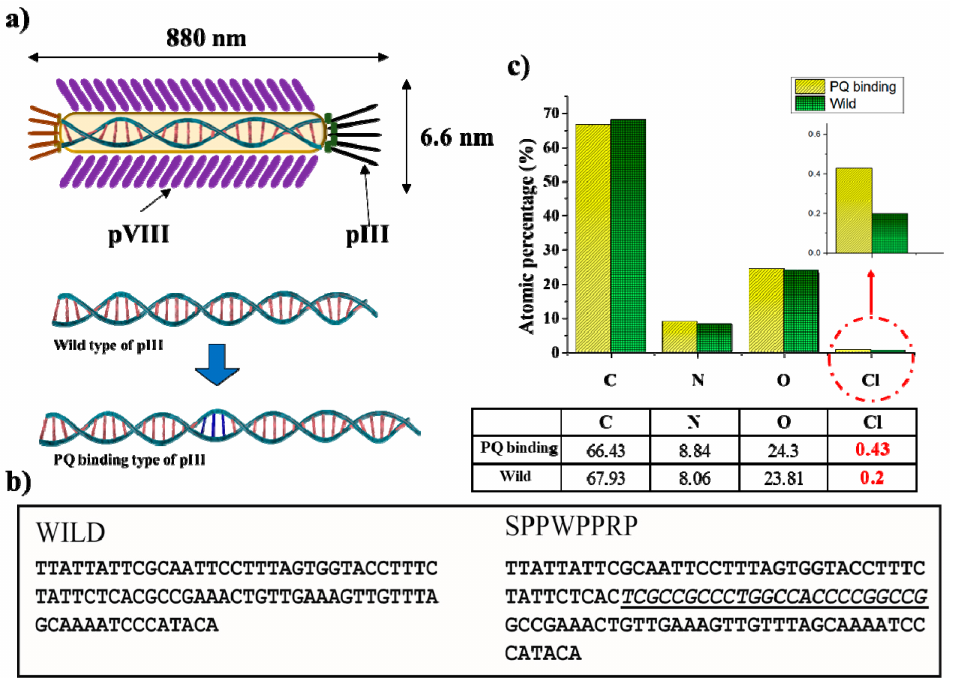
Figure 2. ( a ) Structure of M13 phage. ( b ) pIII genetic engineering site information shows conversion from wild type to SPPWPPRP-type phage (the PQ-binding phage). ( c ) Atomic percentages of biofilter structure measured by